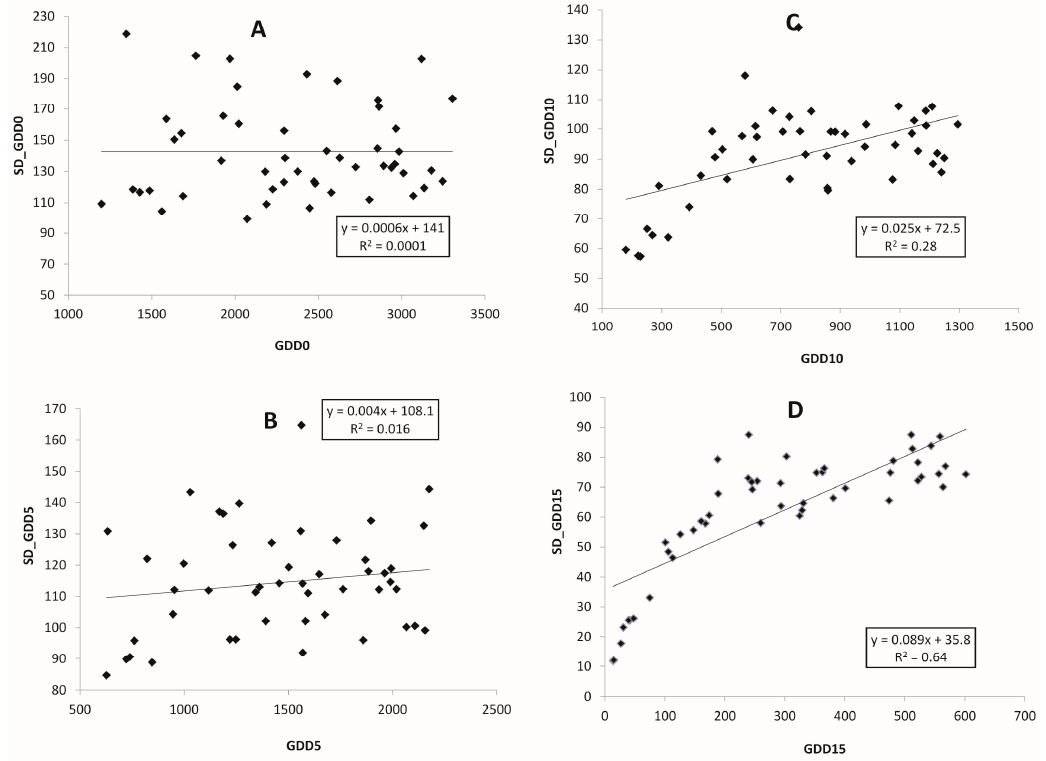
Figure 3. Relationship between growing degree days (GDD) for locations in the Russian Far East for period 1966–2017 for four thresholds: ( A ) GDD0, ( B ) GDD5, ( C ) GDD10, and ( D ) GDD15, and correspondent standard deviation (SD). Atmosphere 2020 , 11 , x